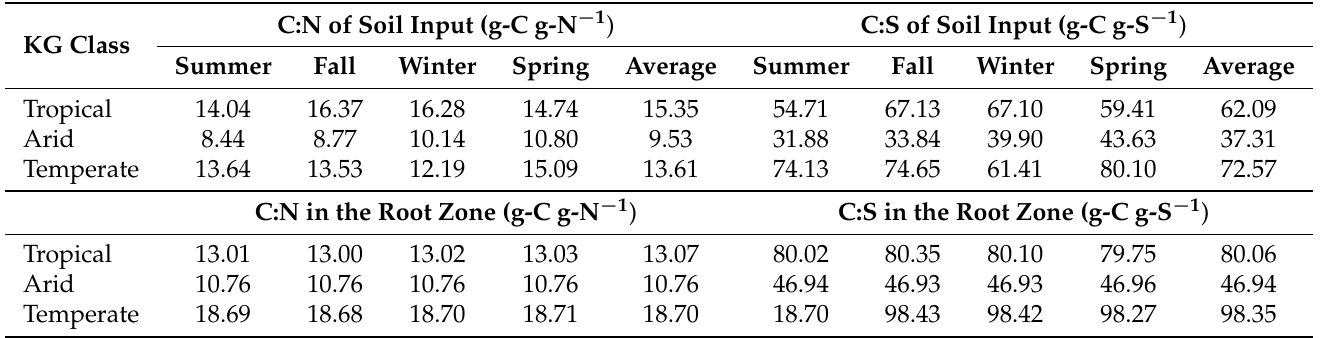
Figure 2. ( a ) Carbon, ( b ) nitrogen, and ( c ) sulfur fractional input contribution in soil in each climatic class and for each season. Tr, Ar, and Te represent tropical, arid, and temperate regions, respectively. NPP BG , NPP AG , Dep., and Ag. Runoff refer to soil organic matter (SOM) input below and above ground, total deposition, and agricultural runoff, respectively. Table 1. Long-term C:N and C:S ratios in soil inputs and root zone in different climatic classes and